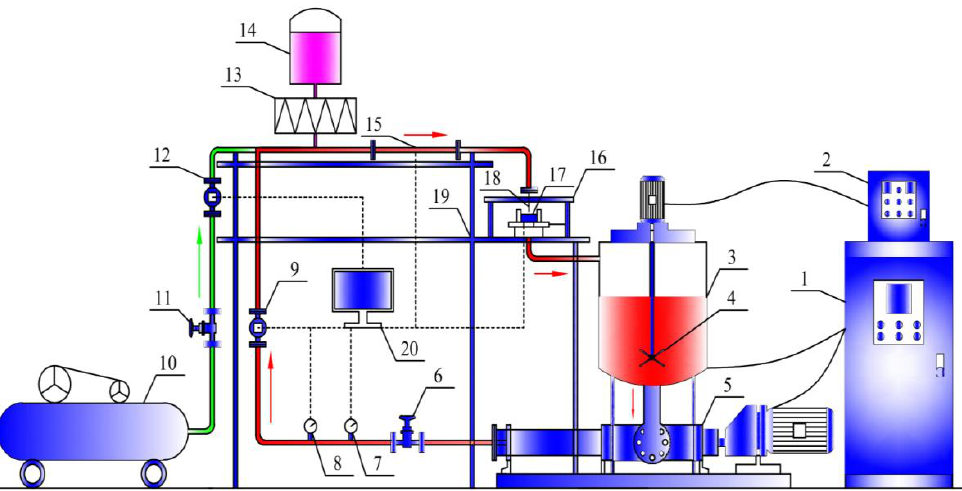
Figure 1. Schematic diagram of the multi-phase flow scour and corrosion experimental bench. 1.